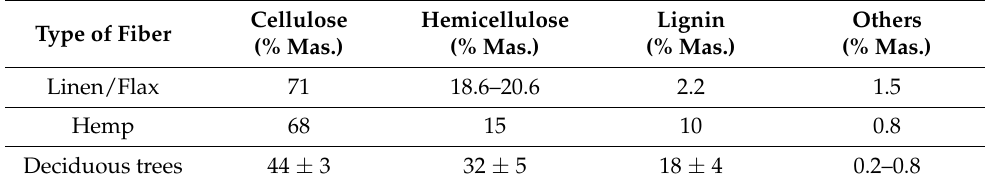
Table 1. Mass fraction of individual used plant fiber components (based on